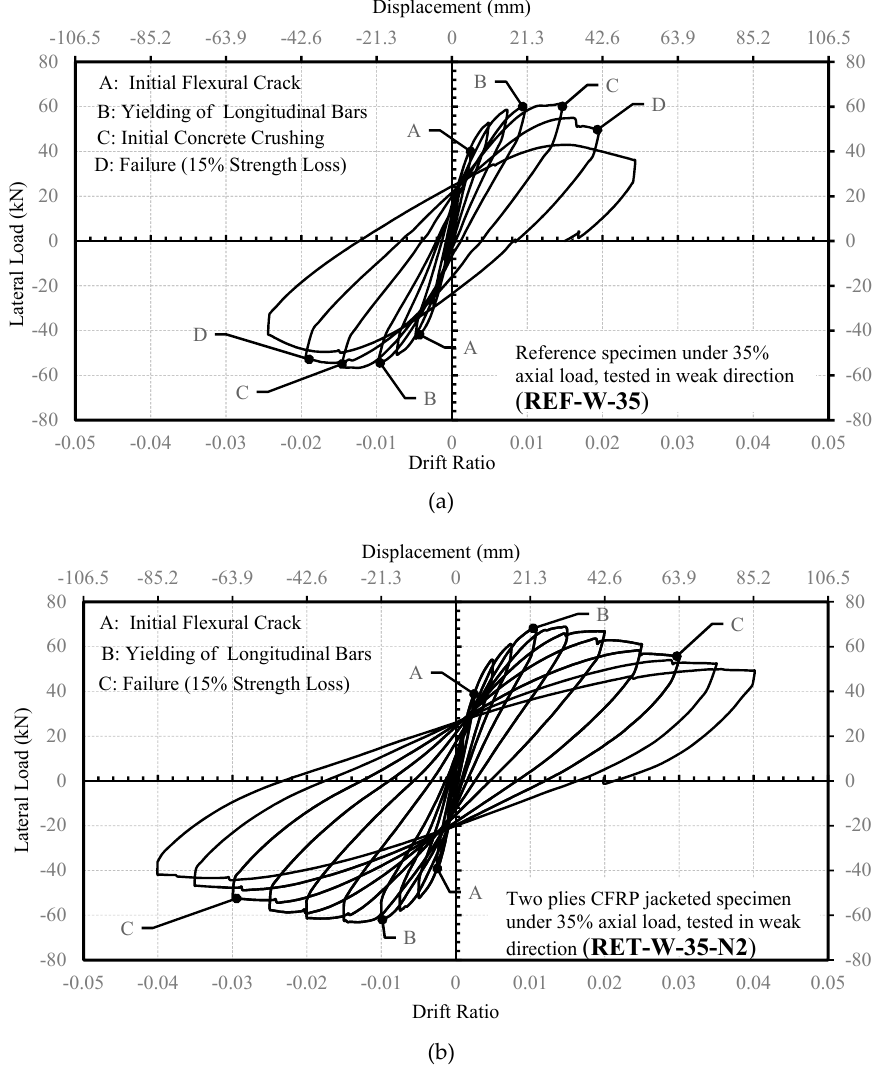
Figure 7. Lateral load-drift ratio relationships for the RW35 series: ( a ) REF-W-35; and ( b ) RET-W-35-N2.